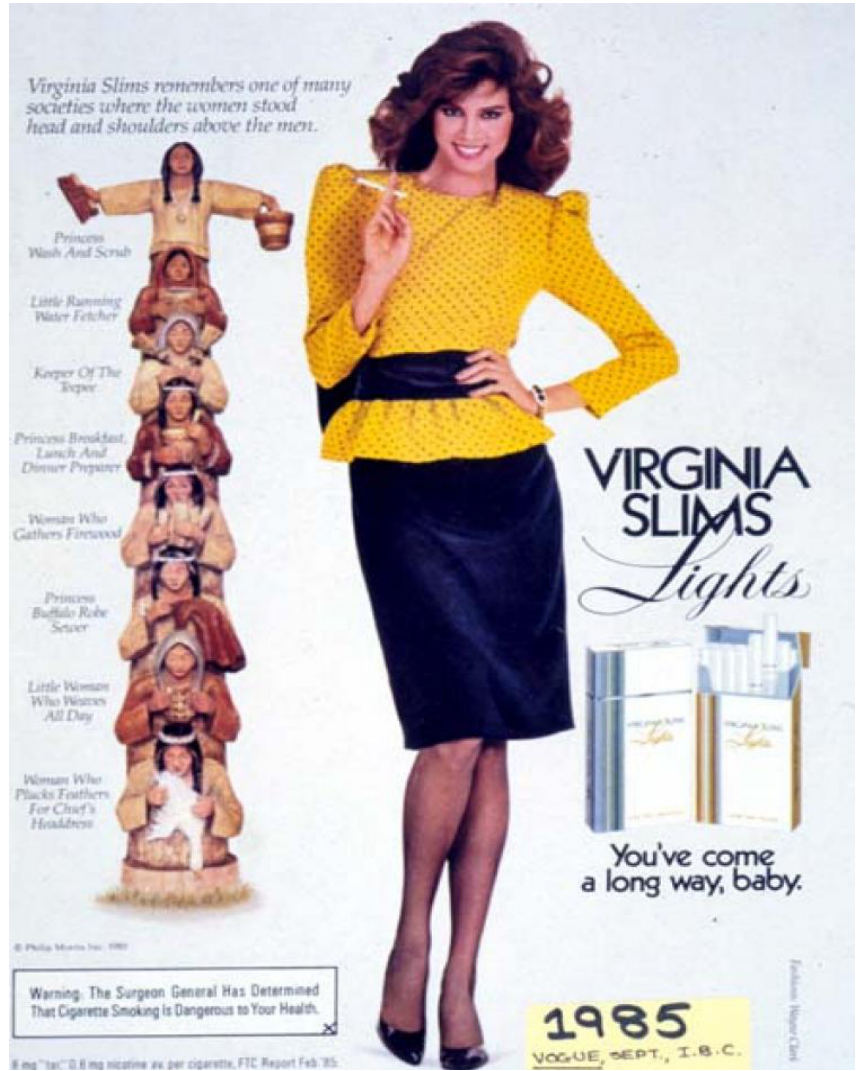
Figure 3. Virginia Slims’ advertisement in Vogue magazine in 1985 depicting a professionally dressed woman smoking next to traditionally (and stereotypically) dressed American Indian women stacked as a totem pole while engaged in various